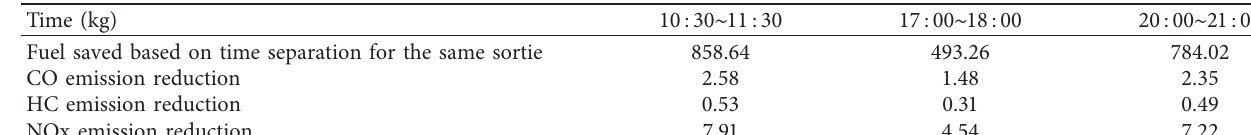
Table 16: Emission reduction of various pollutants.